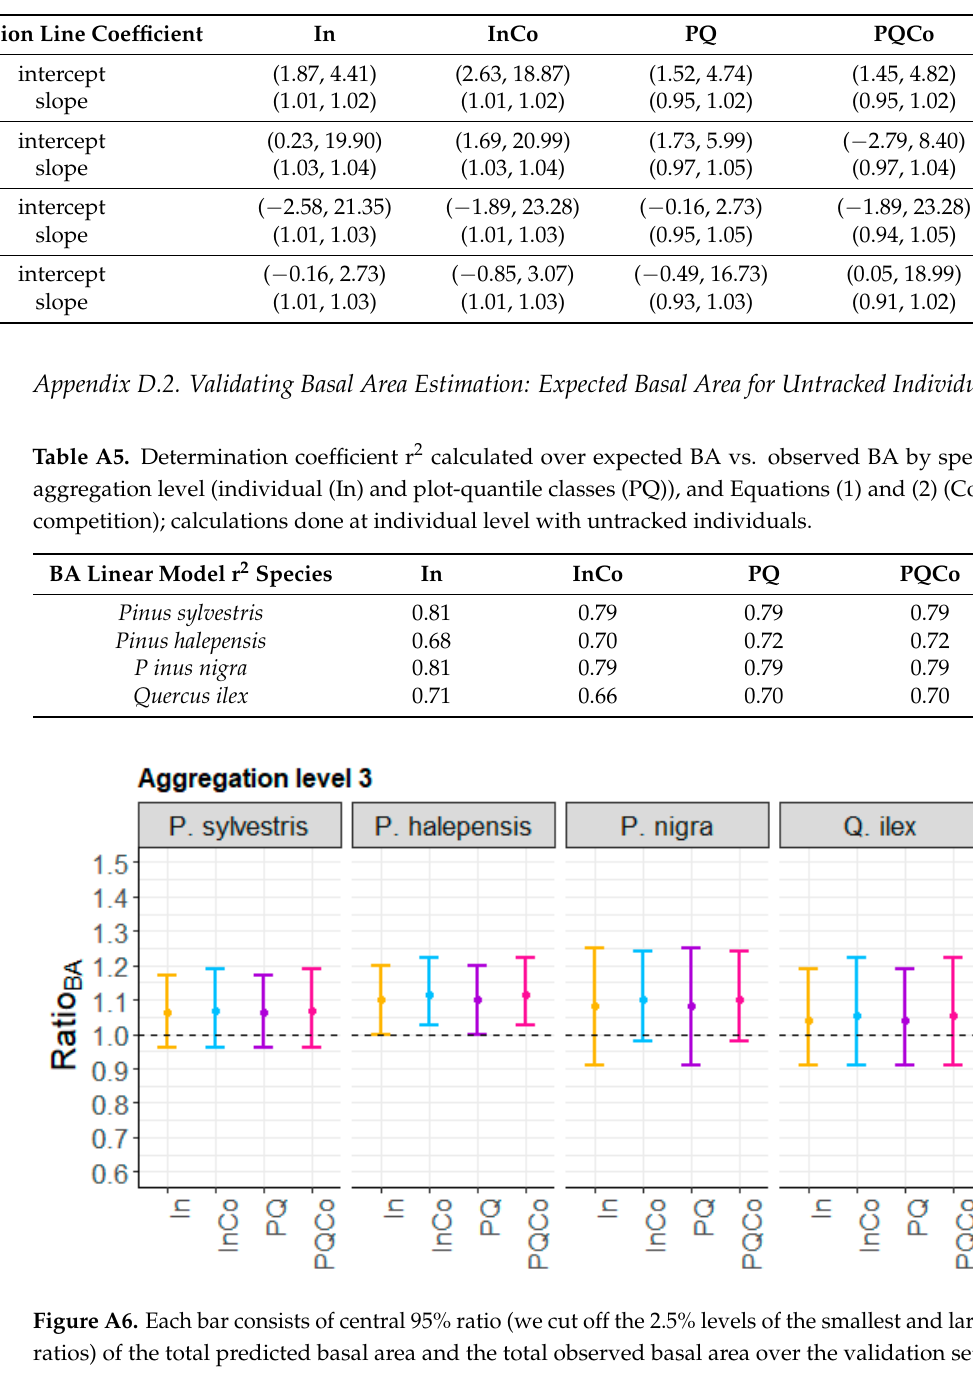
Table A4. Intercept of linear model over predicted BA vs. observed BA (mm 2 ) by species, aggregation level (individual (In) and plot-quantile classes (PQ)), and Equations (1) and (2) (Co for competition).